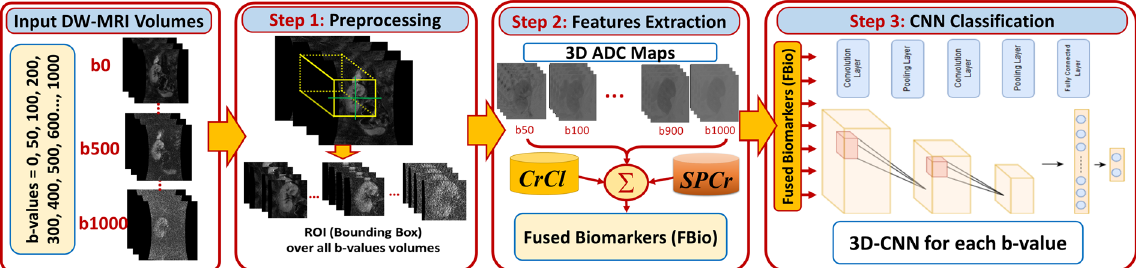
Figure 1. The proposed convolutional neural network (CNN)-based framework for early detection of renal transplant rejection using diffusion-weighted (DW) MRI. This system consists of three main processing steps. In the first step, the histogram of input DW-MRI data is equalized to reduce the noise and inhomogeneity of intensities. Then, an ROI enclosing the kidney in each subject is constructed. In the second step, the 3D ADC maps are estimated for the selected ROI and then fused with the clinical biomarkers, i.e., the creatinine clearance (CrCl) and serum plasma creatinine (SPCr), for allografts classification. In the final step, the fused markers are fed as a 3D input of size 150 × 150 × 24 voxels to the proposed CNN-based classifier to classify renal allografts into non-rejection (NR) and acute rejection